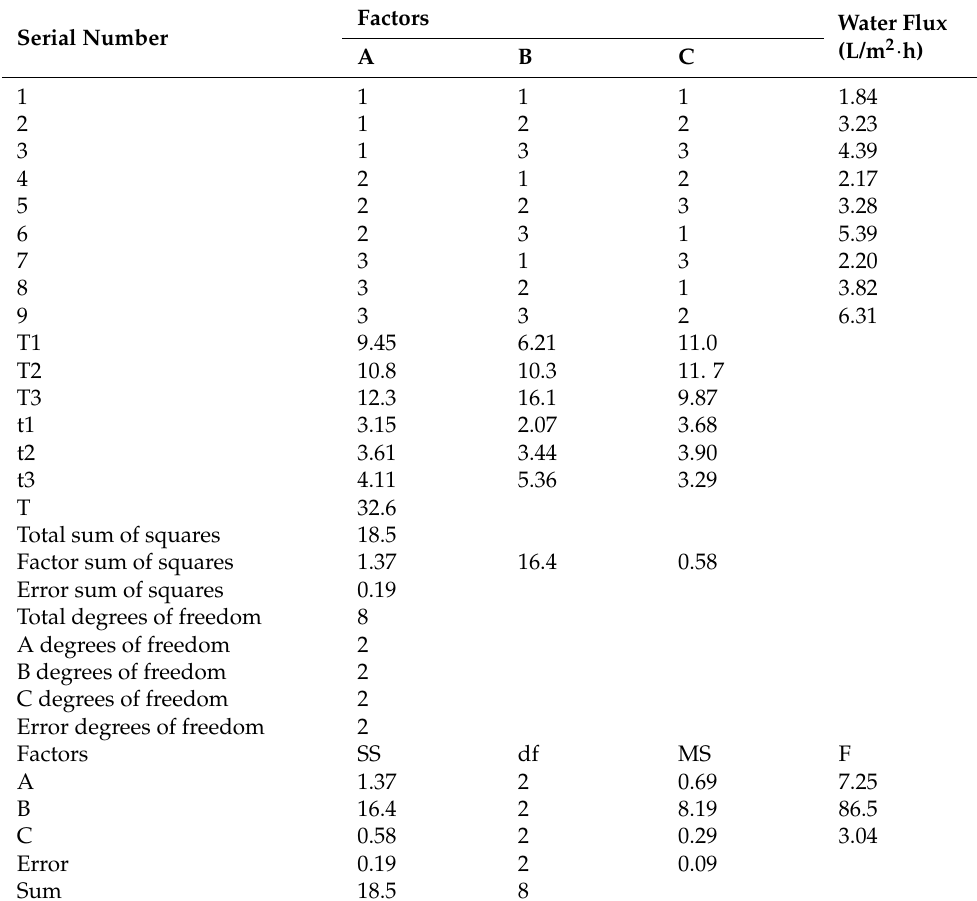
Table 3. Significant analysis of FO membrane